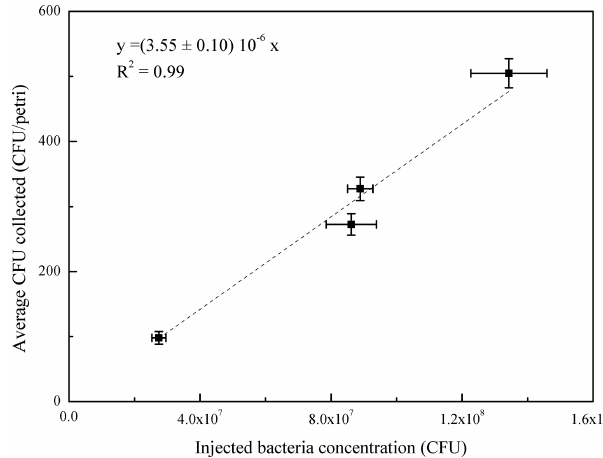
Figure 8. Correlation curve between the number of E. coli bacte- ria injected in ChAMBRe by the Collison nebulizer and the aver- age count on the four petri dishes exposed in each experiment. The injected bacteria were operatively calculated as the product of the concentration (i.e., CFUmL − 1 ) in the bacterial suspension and the injection time